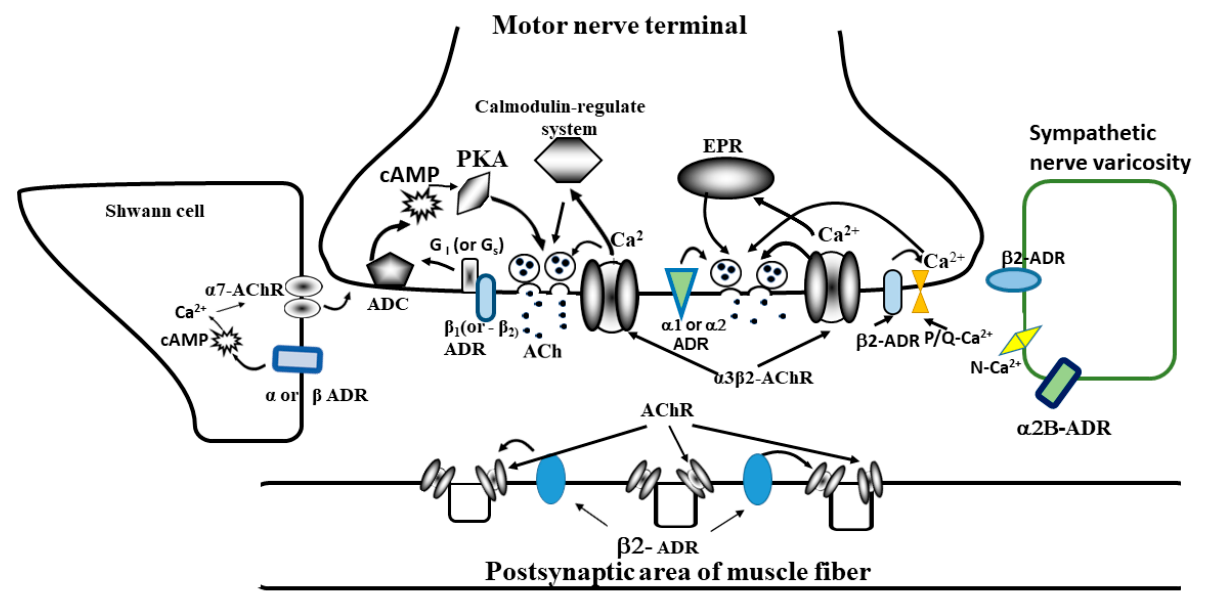
Figure 4. Hypothetical scheme of mammalian NMJ with the sympathetic innervation. ACh-quanta of acetylcholine; ADR—adrenoceptors various types ( α 1, α 2, α 2B; β 1, β 2;); AChR—postsynaptic ACh receptors; α 3 β 2-AChR—neuronal presynaptic ACh receptors; α 7-AChR—neuronal AChR receptors in Schwann cell; ADC—adenylate cyclase; cAMP—cyclic adenosine monophosphate; PKA—protein kinase A; EPR—endoplasmic reticulum; Gi or Gs—G-protein; P/Q-Ca 2+ — voltage dependent calcium channel P/Q type; N-Ca 2+ —voltage dependent calcium channel N type. Orange arrows show possible action the adrenoceptor’s activation.